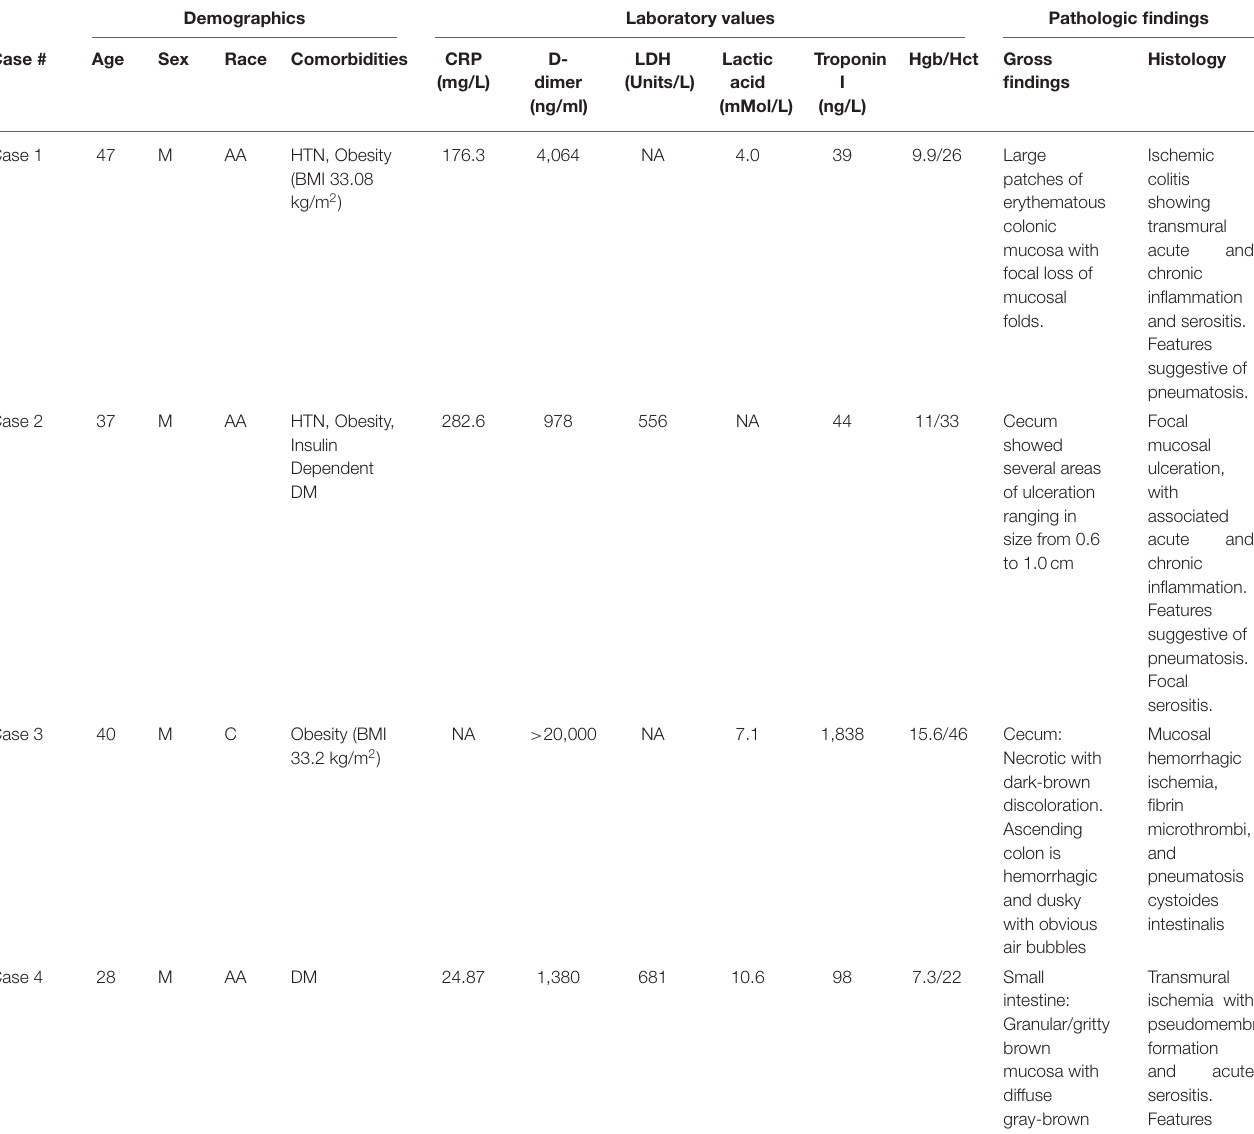
TABLE 1 | Patients’ demographic, laboratory values and pathologic